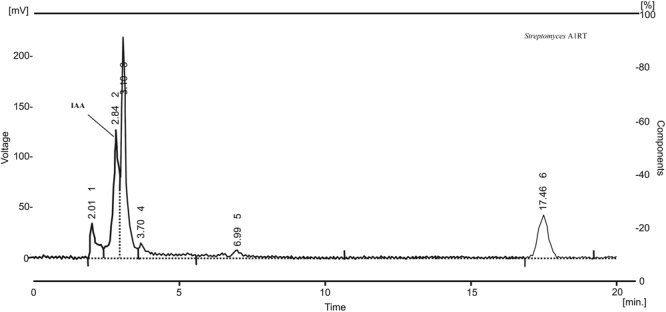
HPLC chromatogram of an extract from Streptomyces A1RT. The peak for indole-3-acetic acid (IAA) is shown. The retention time of the peak is identical to a standard sample of indole-3-acetic acid.